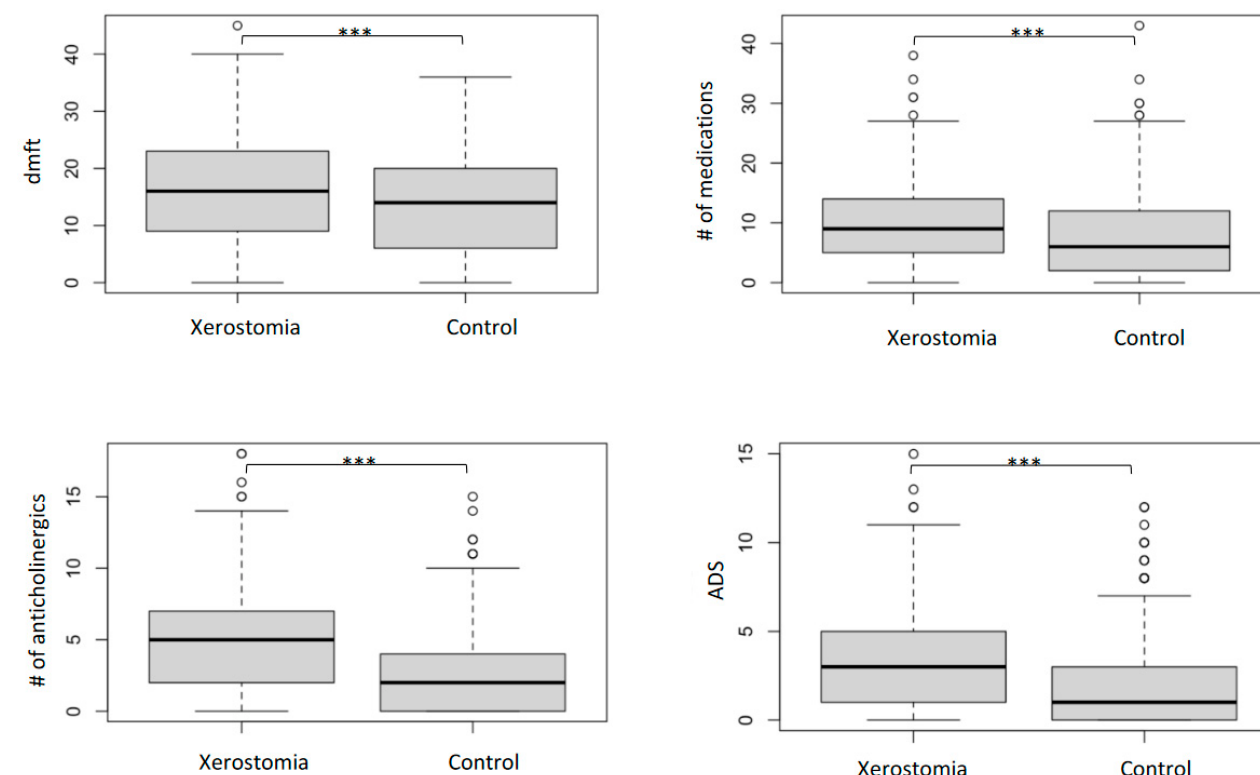
Figure 2. DMFT, number of medications, number (#) of anticholinergic medications, and ADS in the xerostomia and control groups. (Mann-Whitney U tests, boxplots represent the median and quartiles, *** p -value < 0.001).